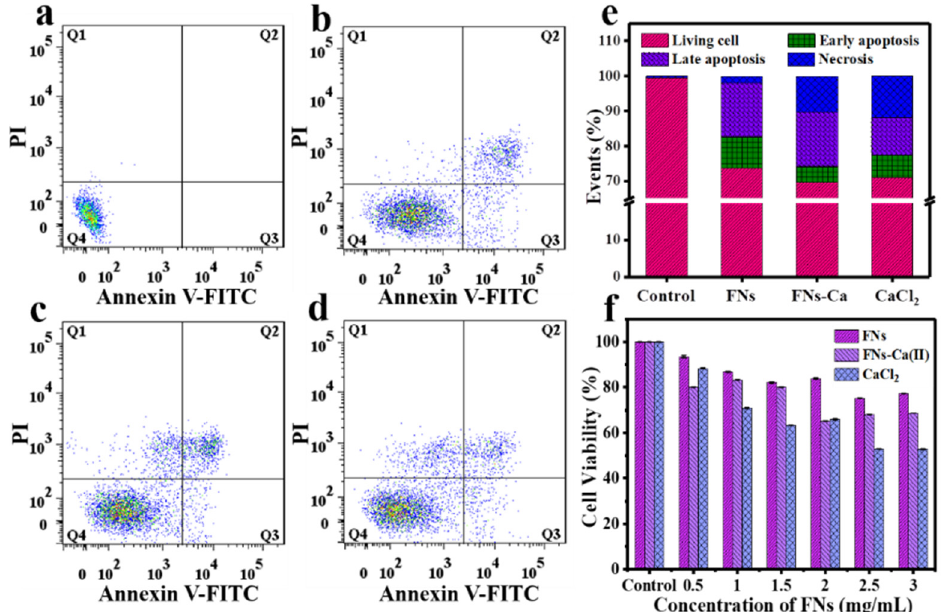
Figure 7. Flow cytometry characterization of Caco-2 cells in control ( a ), 1 mg mL − 1 of FNs ( b ), 1 mg mL − 1 of FNs-Ca(II) ( c ), and 1 mg mL − 1 of CaCl 2 ( d ). ( e ) Relative apoptosis of cells treated with FNs, FNs-Ca(II), and CaCl 2 . ( f ) Cytotoxicity of Caco-2 cells treated with FNs, FN-Ca(II), and CaCl 2 .